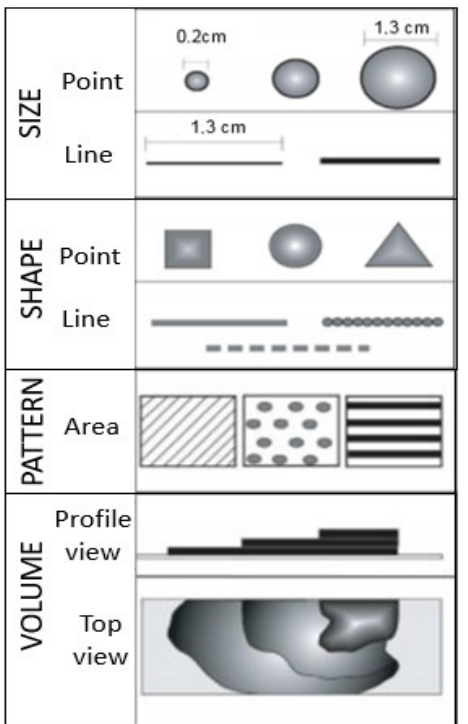
Figure 1. Tactile Graphic Variables. Source: Adapted from Nogueira [Loch],